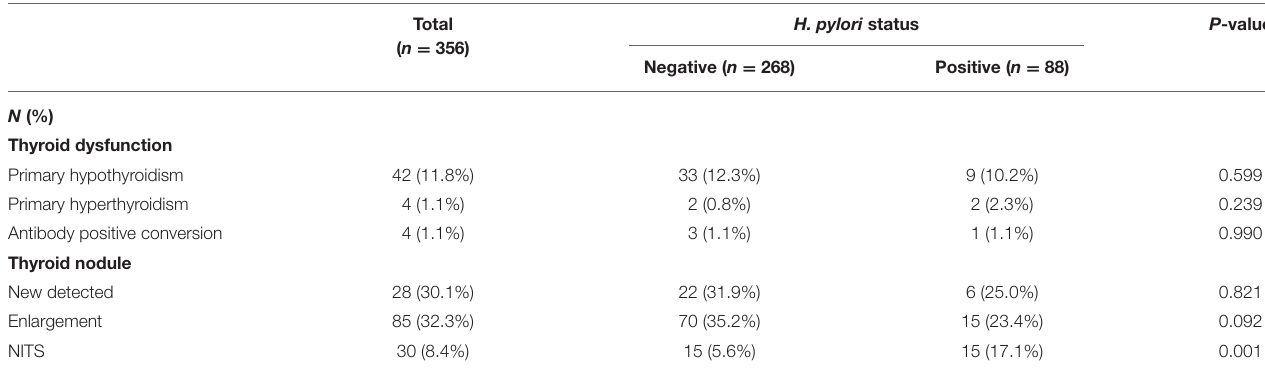
TABLE 3 | Thyroid functions after 5 years of